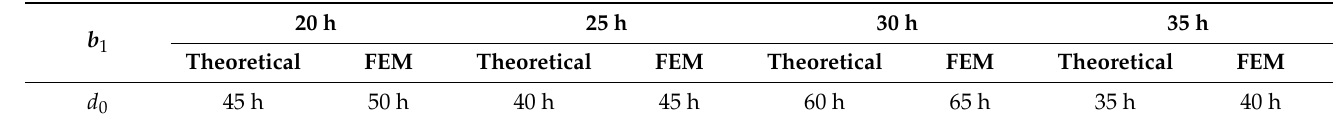
Table 2. The safe distance d 0 between the two resonant units under different electrode width b 1 of Ru-A.